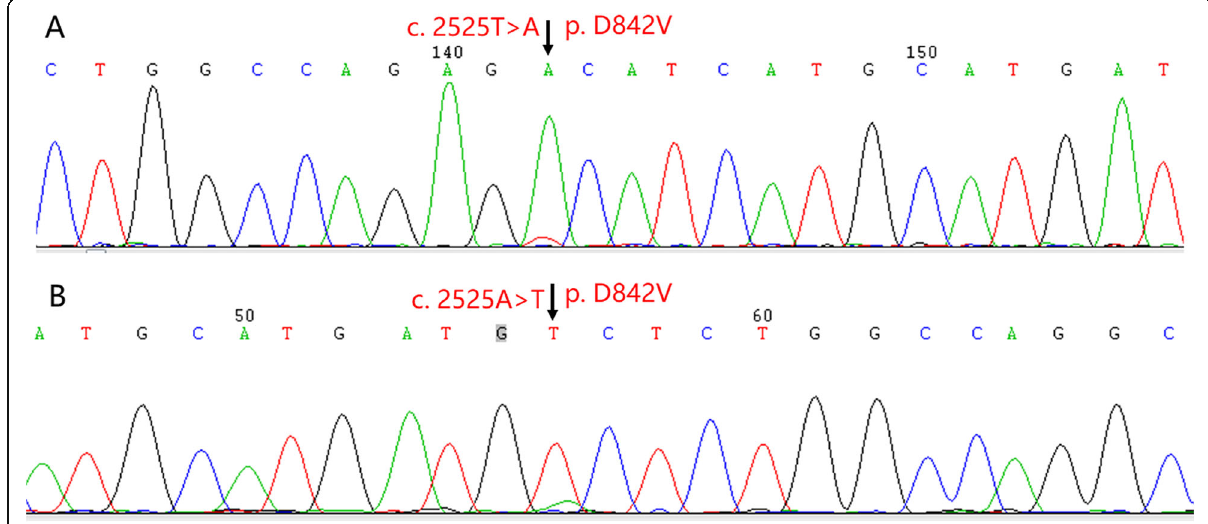
Fig. 4 Sanger sequencing detected a c.2525A > T, p.D842V mutation at exon 18 of PDGFRA for the GIST in this case. Panel a displays the forward sequencing result, and Panel b reveals the reverse sequencing